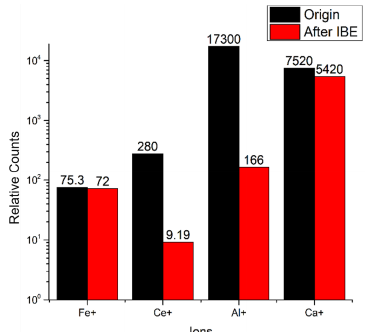
Figure 1. The relative concentration of metal impurities detected by time-of-flight secondary ion mass spectrometry (TOF-SIMS).